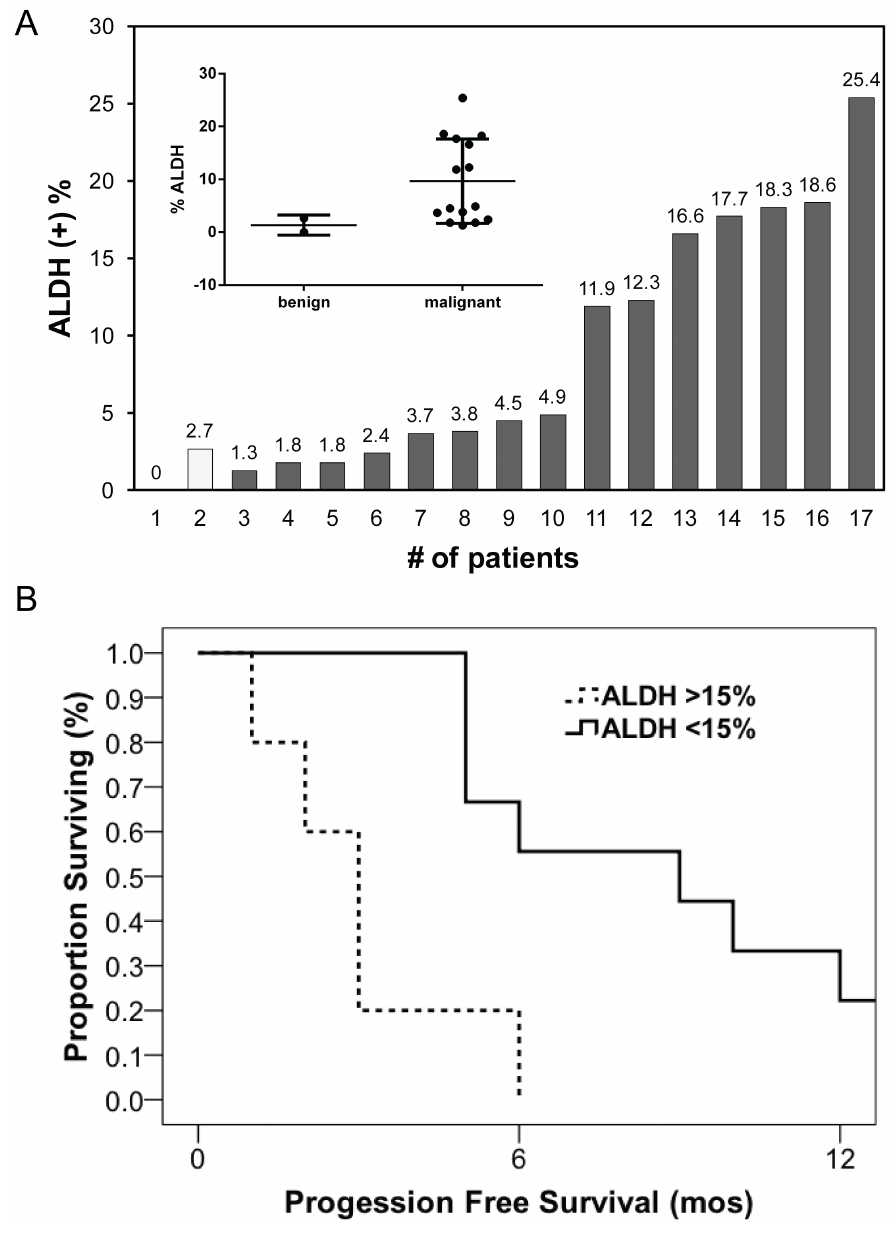
Figure 2. ALDH1A1 status correlates with progression free survival in ovarian cancer patients. Ascites from 15 consecutive patients with primary advanced stage III/IV ovarian cancer and 2 from benign (Miegs syndrome) was obtained and analyzed for percentage of ALDH + cells through ALDEFLUOR assay. The histogram in inset shows the percent of ALDH + cells in benign and malignant ascites (A). The clinicopathologic information from the ovarian cancer patients were correlated with the percent of ALDH + cells in their ascites and evaluated progression free survival with ALDH HIGH ( . 15% ALDH) to ALDH LOW ( , 15% ALDH) patients (3 vs. 9 months, respectively; p , 0.01) (B). doi:10.1371/journal.pone.0107142.g002 ability to form colonies in soft agar, demonstrating a 2.5-fold decrease in the colonies ( p , 0.01) (Figure 4C). Similarly, down- regulation of ALDH1A1 alone significantly sensitized inherently platinum resistant A2780/CP70 cells to carboplatin. Considering IC 50 doses required (82.9 m M and 43.8 m M for negative control and shALDH1A1 cells respectively) for these cells, about 50% reduction in carboplatin dose is evident for ALDH1A1 knockdown cells ( p , 0.001) (Figure 4D). Together, these data suggests that ALDH1A1 status is one of the critical factors in maintaining stem- like cell properties and platinum resistance in ovarian cancer.